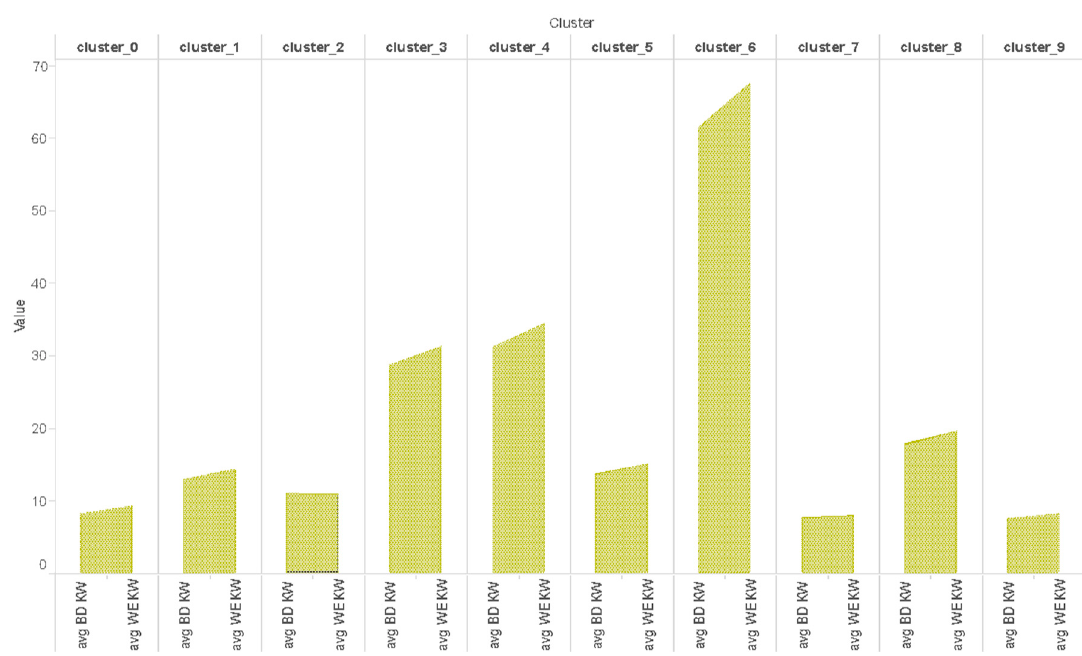
Figure 8. Average usage on weekdays (Monday to Friday) and weekend (Saturday and Sunday).